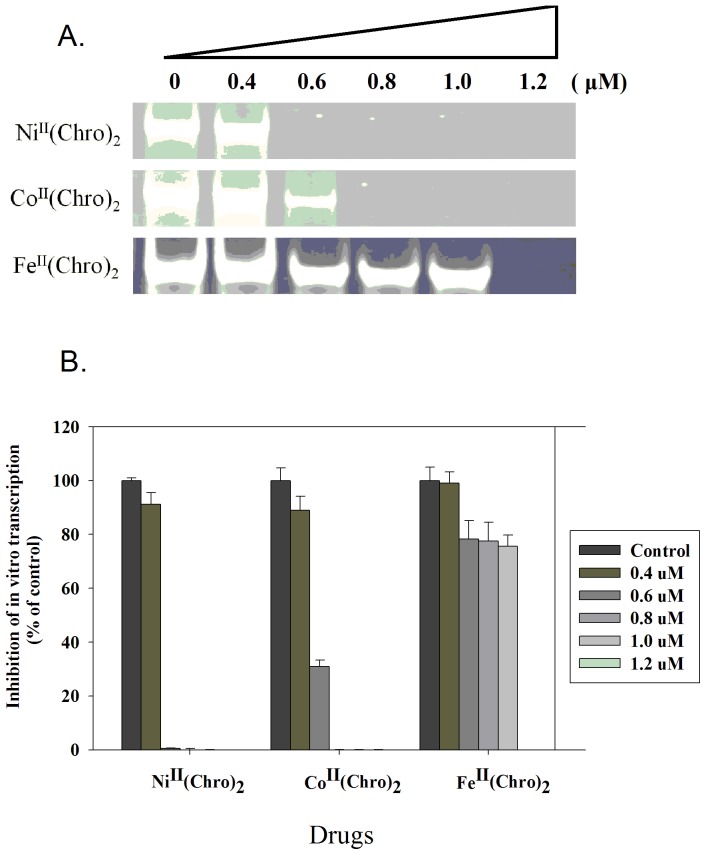
Inhibition of in vitro transcription by Fe(II)-, Co(II)-, and Ni(II)-containing dimeric Chro complexes.(A) The effects of CoII(Chro)2, FeII(Chro)2, and NiII(Chro)2 at various concentrations on T7 RNA polymerase activity. (B) Quantification of the percentage of RNA polymerase activity on drug inhibition at various concentrations relative to the control (no drug treatment). The data represent the mean values ±SDs from three separate experiments.